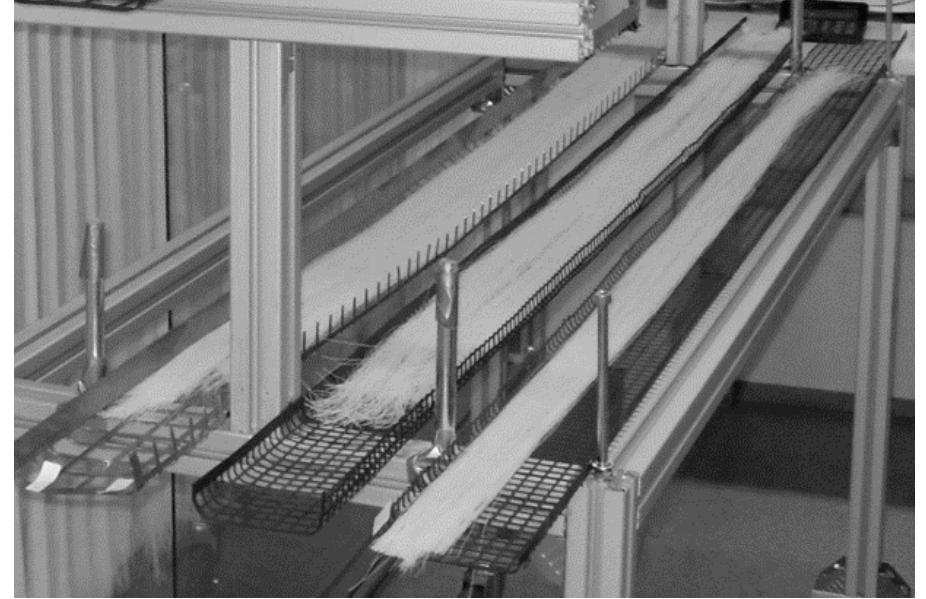
Figure 5. Perforated plates with square openings (10 × 10 mm 2 ) and (20 × 20 mm 2 ).